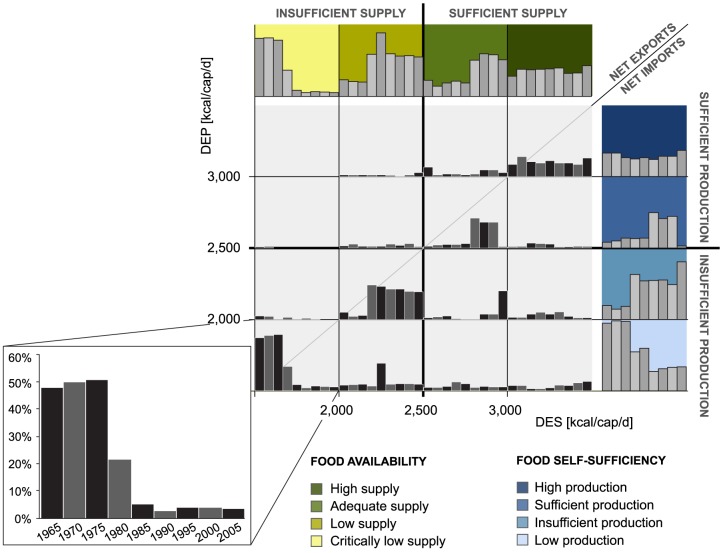
Share of global population living in different food availability (x-axis; measured with DES – dietary energy supply) and food self-sufficiency (y-axis; measured with DEP – dietary energy production) categories during the study period.Bar charts in the end of rows and columns illustrate the sum of each row/column.